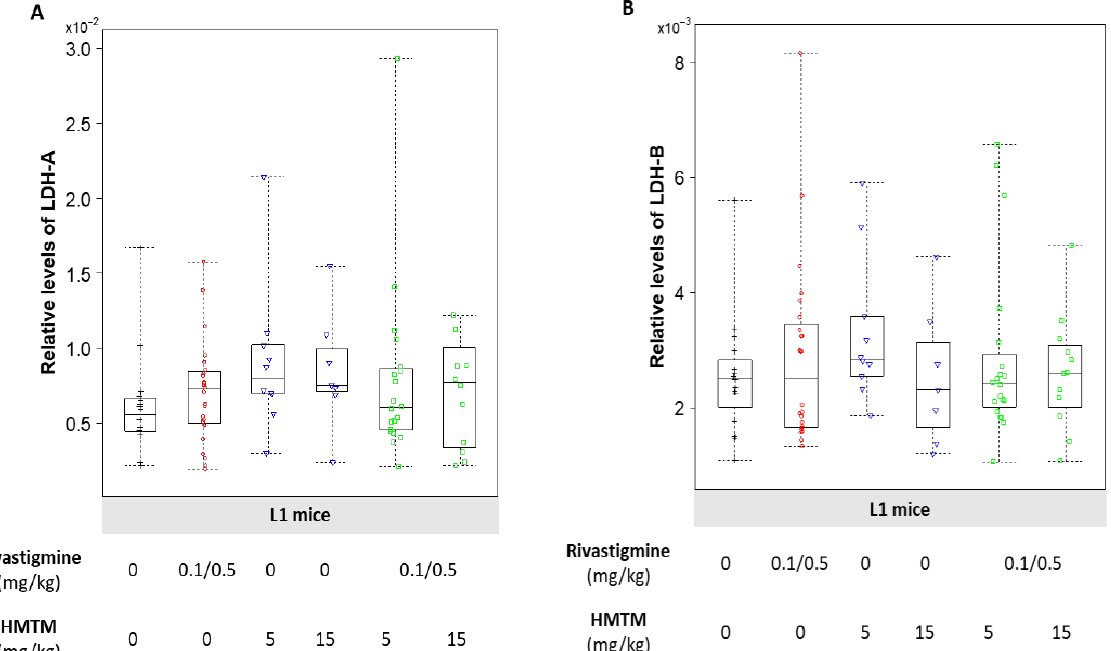
Figure 5. Relative levels of LDH-A ( A ) and LDH-B ( B ) in the brains of L1 mice. HMTM tended to increase the levels of LDH-A in the brains of L1 mice, with rivastigmine preventing the same profile of increase in the LDH-A subunit ( A ). HMTM dosing as either mono- or add-on regimen of administration failed to reveal any changes in the protein levels of LDH-B ( B ). Data are expressed as median values ± IQR ( n = 7–24). Regardless of the doses, the black symbols represent the vehicle group; the red symbols represent the rivastigmine-dosed mice; the blue symbols represent the experimental groups dosed with HMTM; and the green symbols represent the groups dosed with both HMTM and rivastigmine.